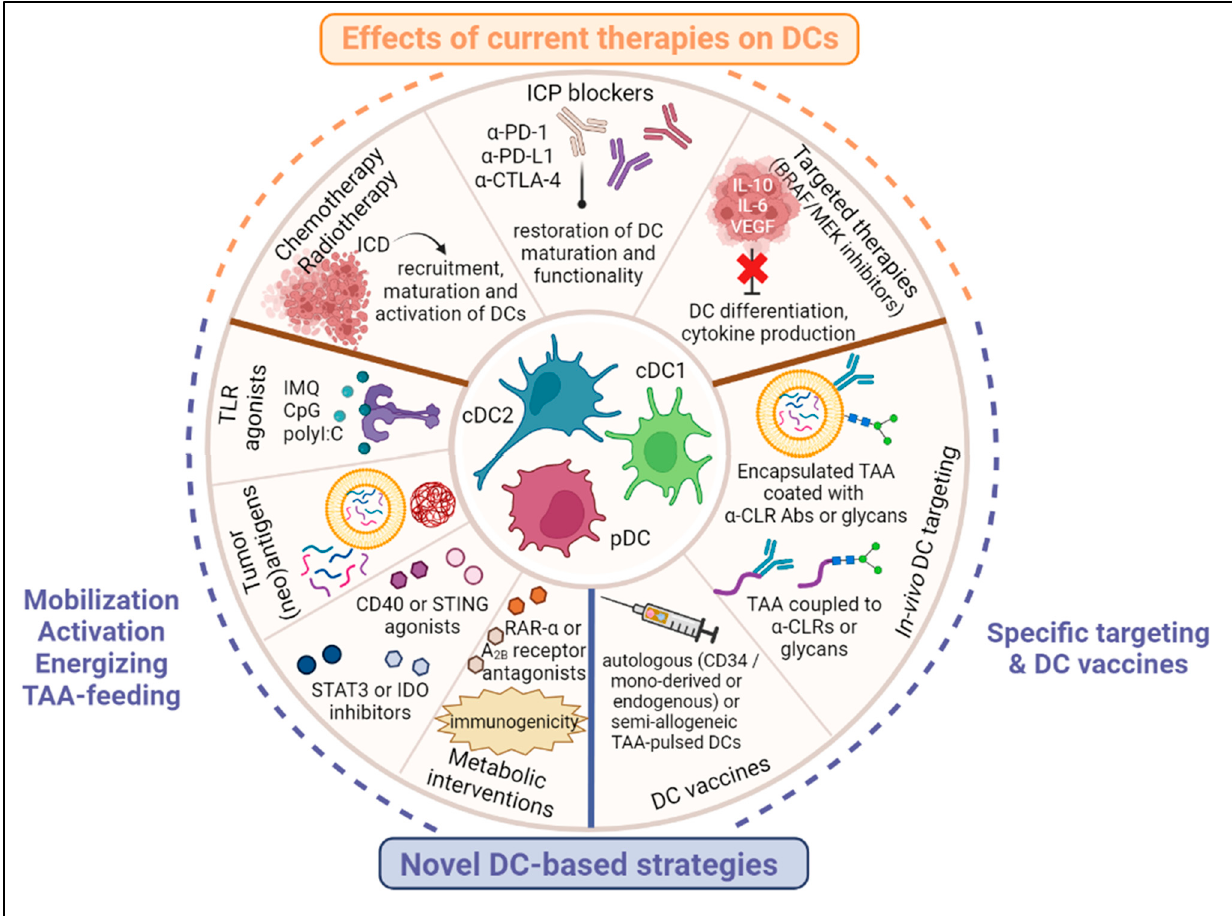
Figure 2. DC-based immunotherapeutic strategies in melanoma. Current therapies such as chemotherapies, immune checkpoint blockers and targeted therapies deployed in melanoma can indirectly positively affect DCs’ recruitment, differentiation, maturation and function. Besides, insights into the mechanisms of DCs’ hijacking by melanoma led to the design of therapeutic strategies that exploit the potential of DCs while preventing their subversion by the tumor. These strategies include approaches that mobilize, activate, energize and feed endogenous DCs, interventions that target specific DC subsets in vivo using TAA coupled to anti-CLR Abs or glycans, and DC vaccines.